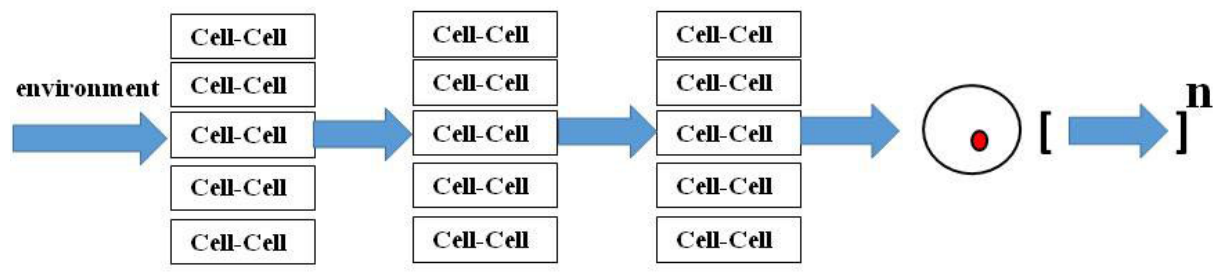
Figure 2. Evolution as Cell-Cell Signaling. Environmental ‘stress’ affects cell-cell communication mechanisms that determine homeostatic control, resulting in genetic ‘mutations’ that modify structure and function